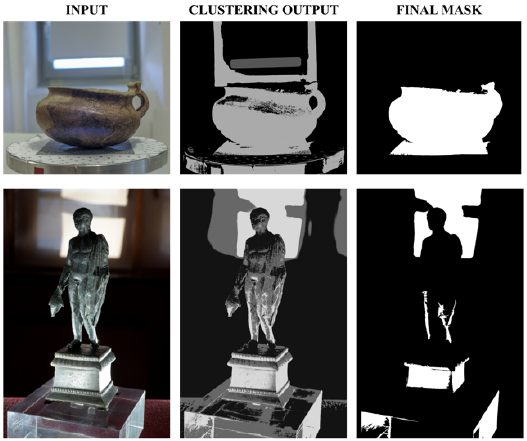
Figure 7. Mask generation with an unsupervised approach with incomplete and inoperative results.